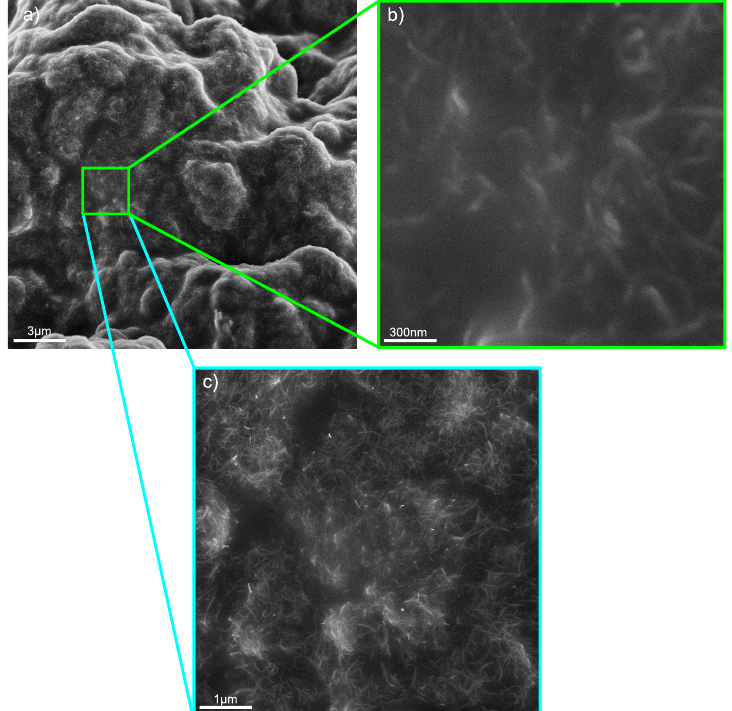
Figure A6. SEM images for CNTN at magnifications of ( a ) 10k, ( b ) 150k and ( c )